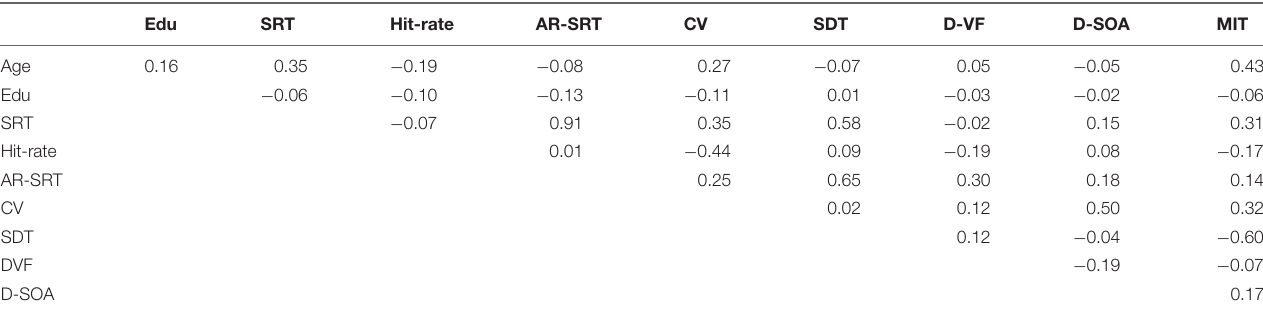
TABLE 4 | Correlation matrix for Experiment